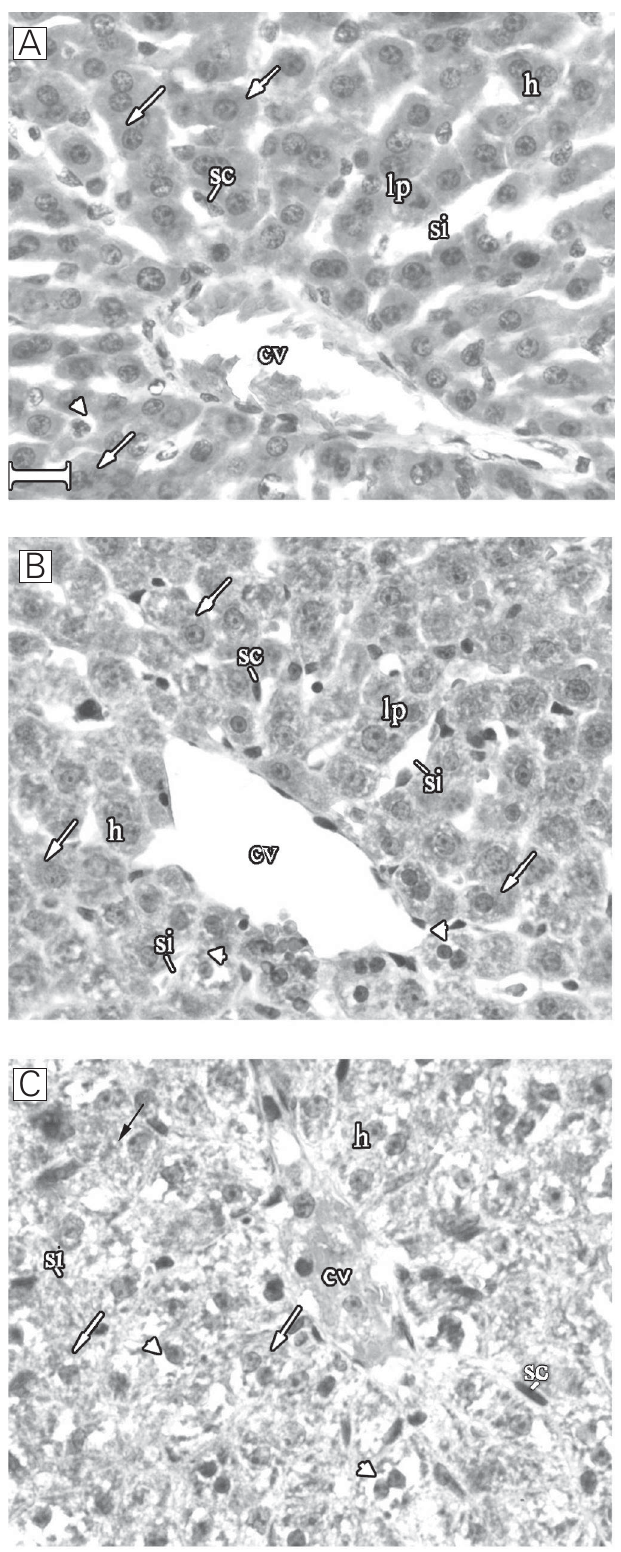
Figure 1. A , Liver tissue from a rat treated with hyper- baric oxygen before partial hepatectomy (preHBO group). B , Liver tissue from a control rat (recovered under normal ambient pressure after partial hepatecto- my). C , Liver tissue from a rat treated with hyperbaric oxygen after partial hepatectomy (postHBO group). cv = central vein; h = hepatocyte; lp = liver plate; sc = sinusoidal lining cell; si = sinusoid; arrows = cytoplas- mic granules; arrowheads = cytoplasmic vacuoles. He- matoxylin-eosin, 40X. Bar = 0.2 mm for all